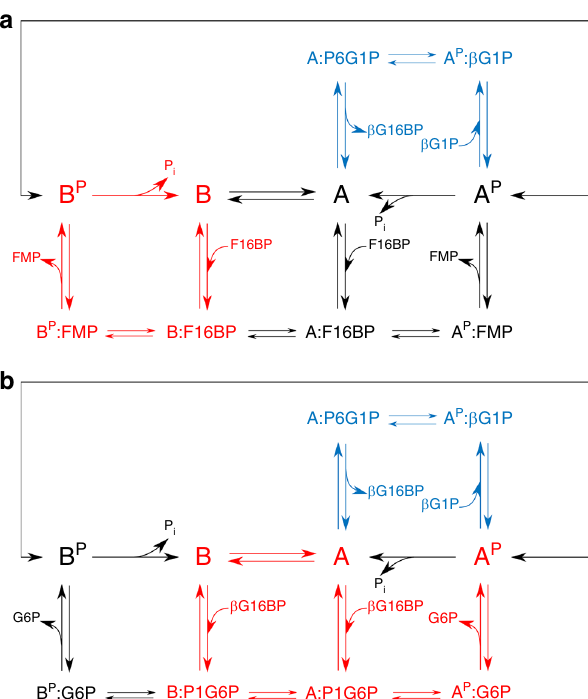
Fig. 6 Kinetic model of β PGM activity. a , b Reaction schemes for β PGM WT as conformer A or conformer B with different phosphorylating agents. The favoured pathways are shown (red text) for β PGM WT with a F16BP as a phosphorylating agent and b β G16BP as a phosphorylating agent. The β G16BP generating steps are highlighted in blue text. Fructose monophosphate (FMP) is either fructose 6-phosphate or fructose 1-phosphate. The complexes X:P1G6P ( X = A or B) and A:P6G1P denote explicitly the orientation of β G16BP bound in the active site. The double- headed arrows connecting A P and B P indicate that these species interconvert with a multi-second exchange rate, similar to that described for the interconversion of conformer A and conformer B.